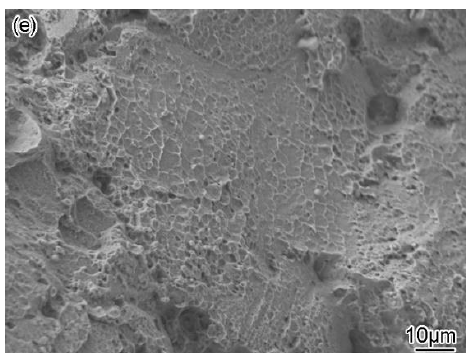
Figure 7. Fracture morphology of HIPed alloy after the stress-rupture at 705 °C/897 MPa: ( a ) low magnification morphology, ( b ) the fracture source region, ( c ) steps and small planes in the propagation region, ( d ) tearing edges and steps in the propagation region, and ( e ) the shear lip region.